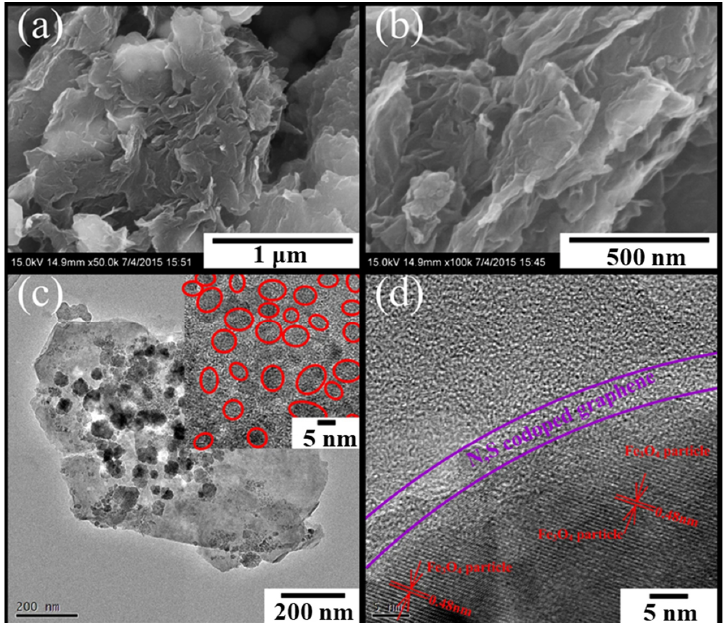
Figure 3. FE-SEM and TEM images of the synthesized NSG/Fe 3 O 4 composites: ( a ) FE-SEM images reveal Fe 3 O 4 nanoparticles encapsulated in N, S co-doped graphene nanosheets; ( b ) FE-SEM images; ( c ) TEM images show that there are many Fe 3 O 4 nanoparticles distributed and encapsulated in N, S co-doped graphene nanosheets; ( d ) high-magnification TEM images showing that Fe 3 O 4 nanoparticles are contained in N, S co-doped graphene nanosheets effectively. Reprinted with permission from Ref. [65]. Copyright 2022 Springer Nature Limited.